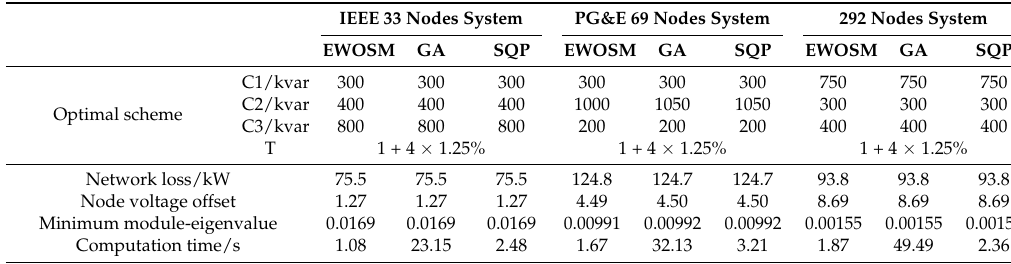
Table A1. The calculation results of three methods in different scales of